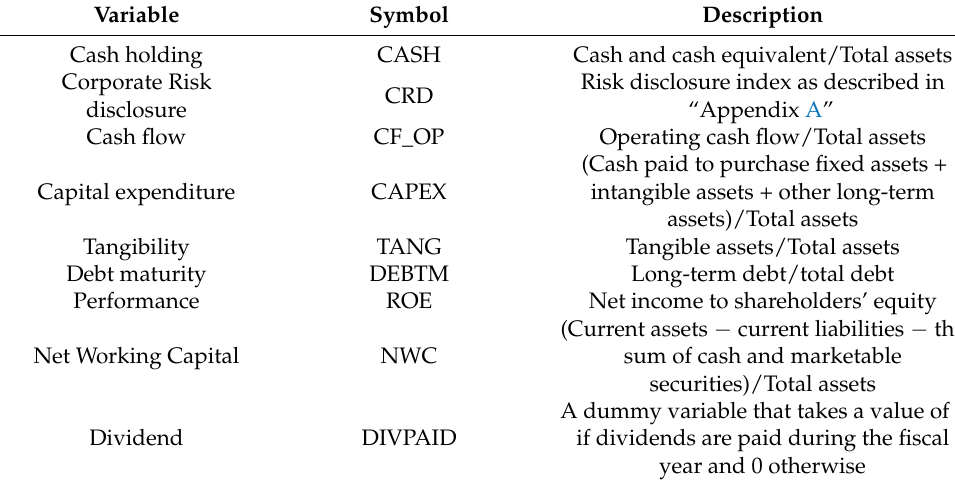
Table 2. Variables’ descriptions.